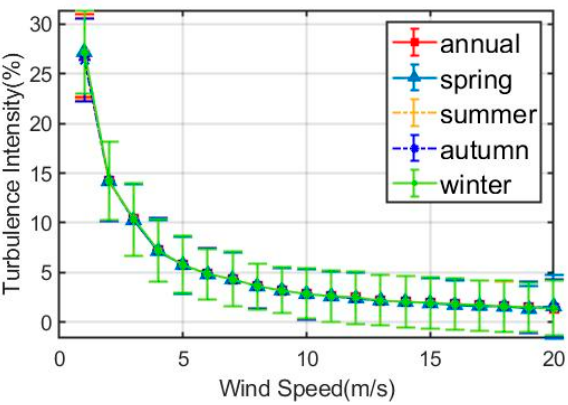
Figure 4. The relationship between turbulence intensity (TI) and wind speed. The solid lines show data binned in 1 m/s classes, where the line shows the mean value and the bars denote plus/minus half a standard deviation (±SD) around the mean.